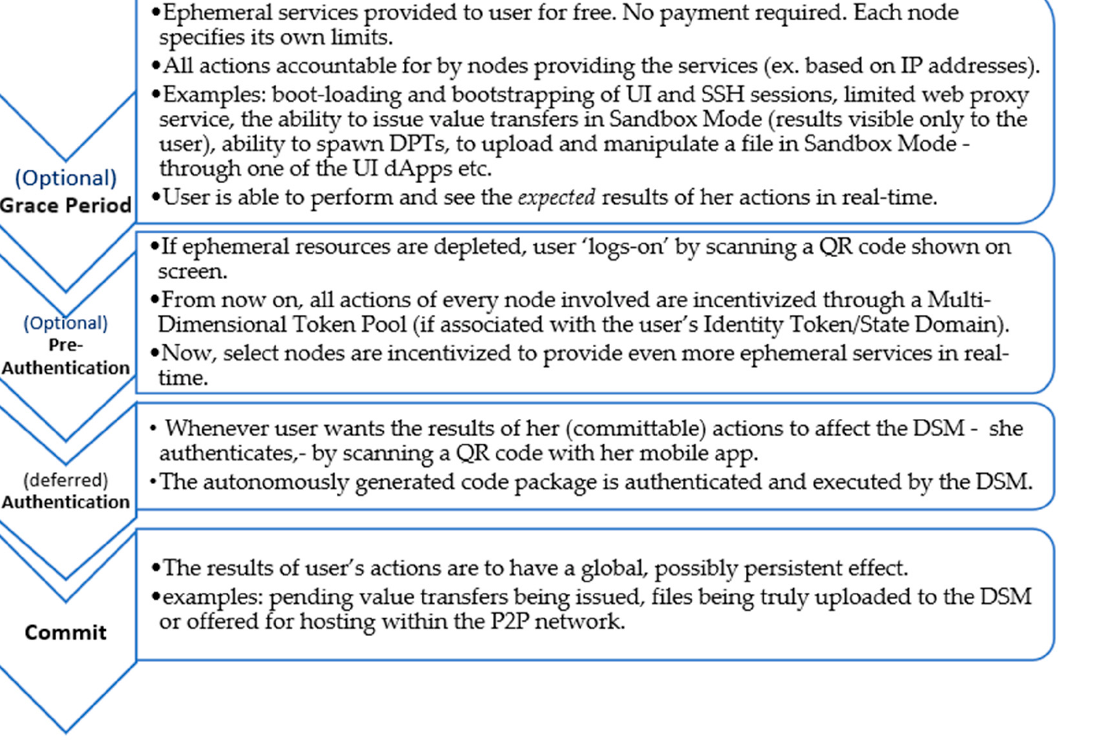
Figure 7. Higher level overview of the deferred authentication functionality.